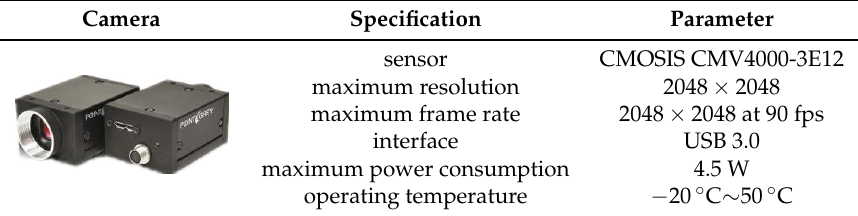
Table 2. The camera parameters.